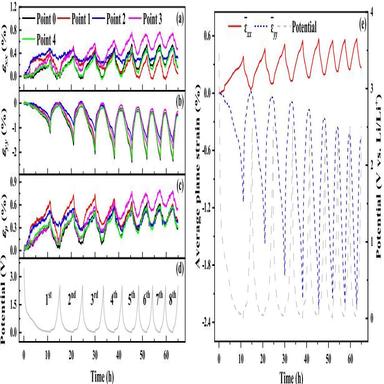
Evolution features of (a) ԑxx, (b) ԑyy and (c) ԑp at the five selected points, (d) potential of the in-situ cell during the first 8 electrochemical cycles, and (e) average plane strain for the selected analysis region.